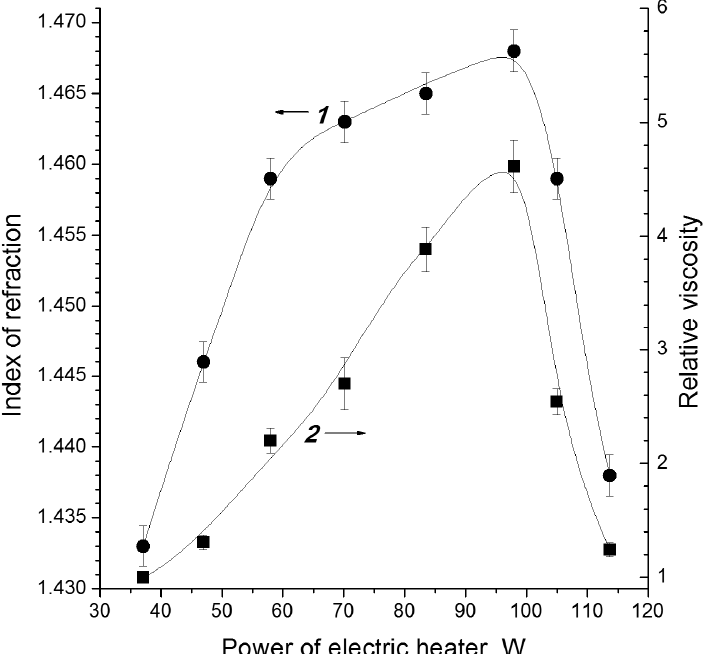
Figure 13. Effect of additional electric heating on refractive index ( 1 ) and relative viscosity ( 2 ) of the condensate distilled from microcrystalline cellulose at dose rate of 0.42 kGy/s and starting temperature of 80 °C